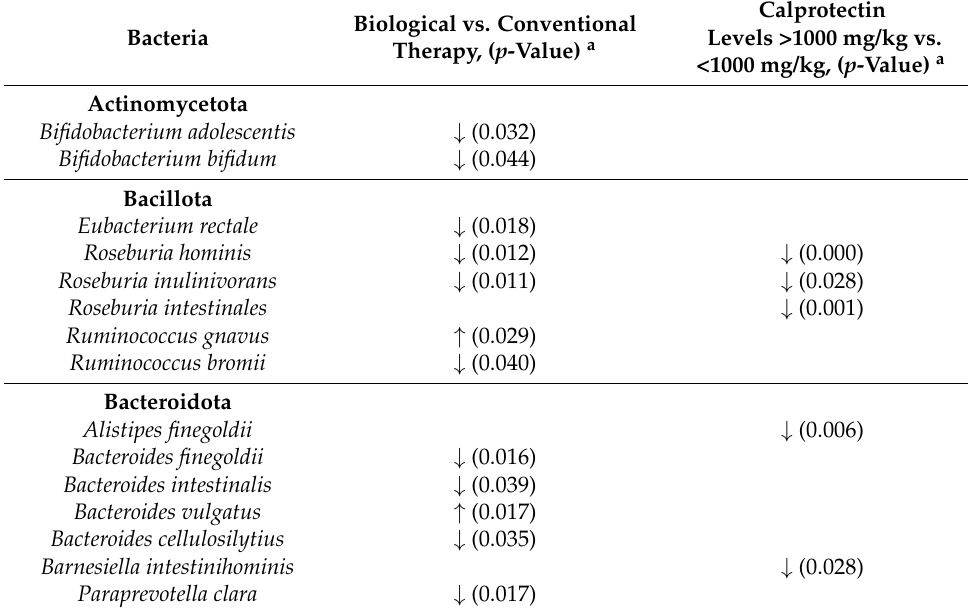
Table 3. Bacterial species exhibiting deviating abundances between medical therapy groups and between groups with high and low calprotectin levels.